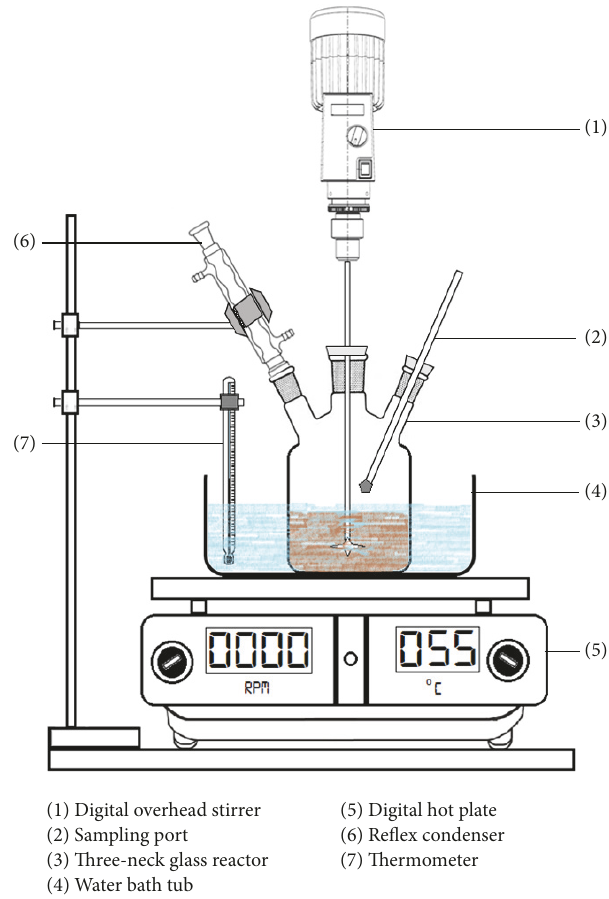
Figure 1: Transesterification experimental setup for JME produc-